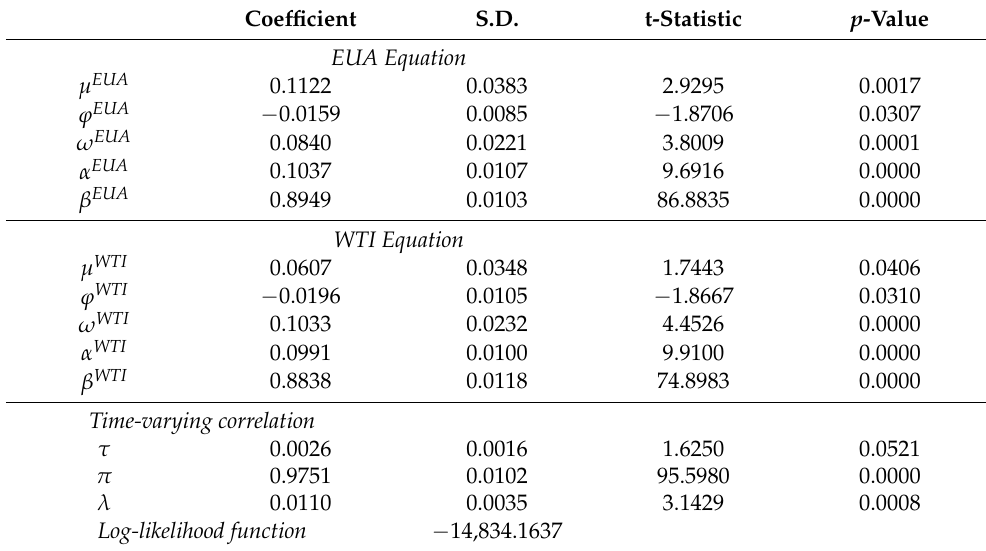
Table 4. Estimated results of the bivariate GARCH-DCC